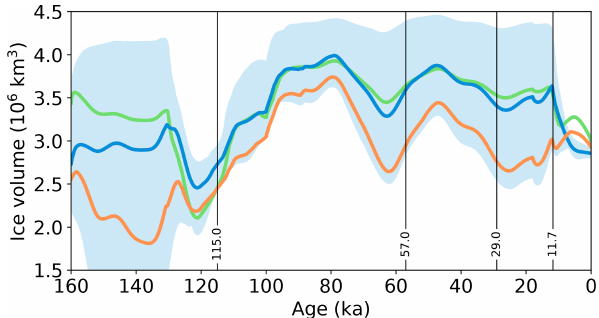
Figure 12. Volume of the Greenland ice sheet as simulated by BEST ice (green), BEST all (blue), the 10% best simulations in the combined RMSE (shading), and the simulation with the lowest combined RMSE based on the Eulerian age tracer (orange). Ver- tical lines highlight the age of the calibration